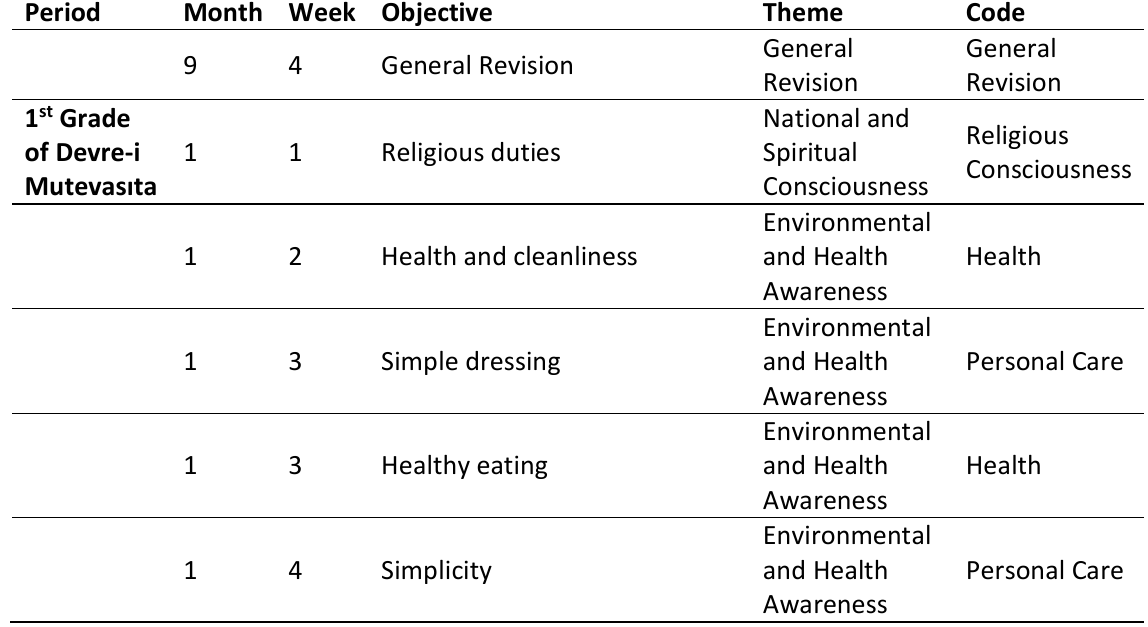
Tablo 2. Objectives, Themes and Values of Devre-i Mutevasıta 1 st and 2 nd Grades in the 1913 Curriculum of Musâhabât-ı Ahlâkiyye [Conversations on Morality] Course